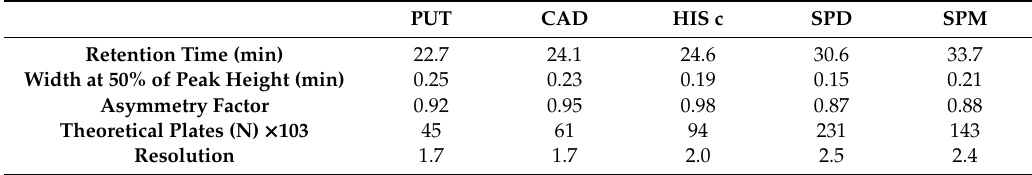
Figure 6. Emission spectra of ( A ) cadaverine and ( B ) spermine pyrene derivative chromatographic peaks. Retention times approximately 24 and 33 min, respectively.